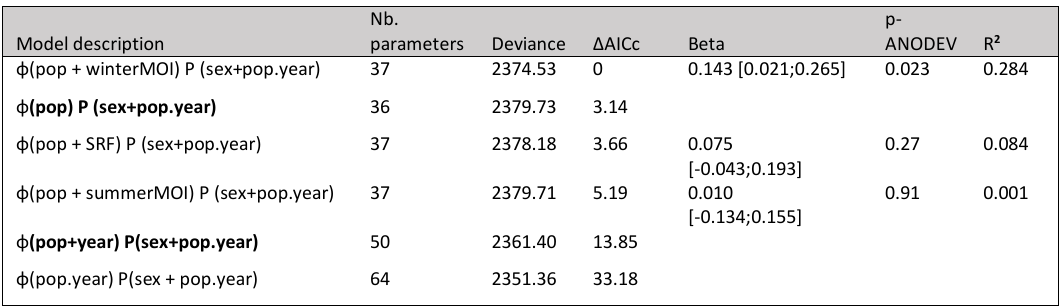
Table S4 : Model selection procedure and significance of the effects of three large-scale climatic indices on adult survival ( φ ) based on a restricted dataset (three populations over the period 1985-2000, see main text for details). Starting yearly dependant and constrained model for the ANODEV are highlighted in bold. AICc of the best model (first raw of the table) is 2449.71. SRF = Early Summer Sahel Rainfall; MOI= Mediterranean Oscillation Index. The values of R2 provided correspond to the proportion of temporal variance in survival explained by the model covariate, computed through an analysis of deviance. The Beta column provides the estimate associated with each temporal covariate with its 95% confidence interval. Nb. Model description parameters